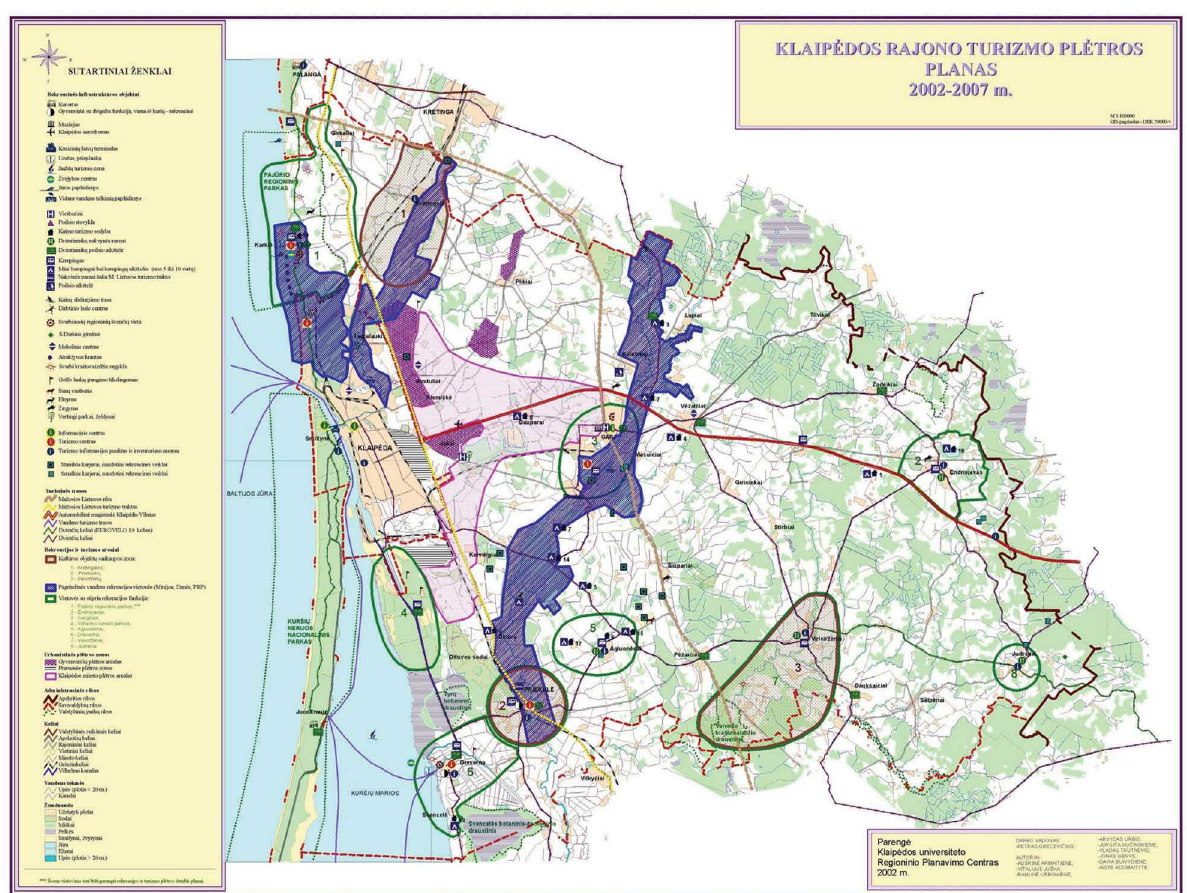
Fig 2. Tourism development plan of Klaipėda region